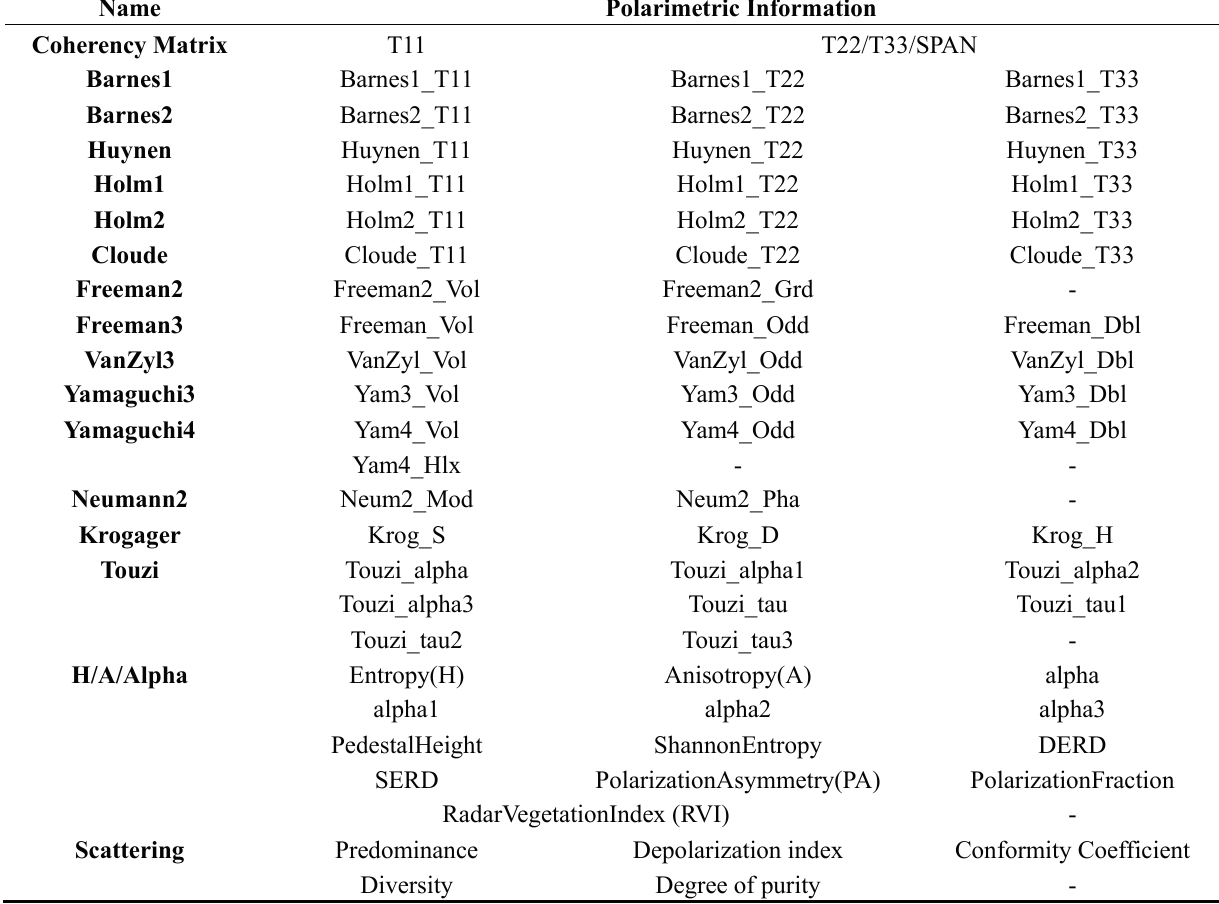
Table 2. Polarimetric Information